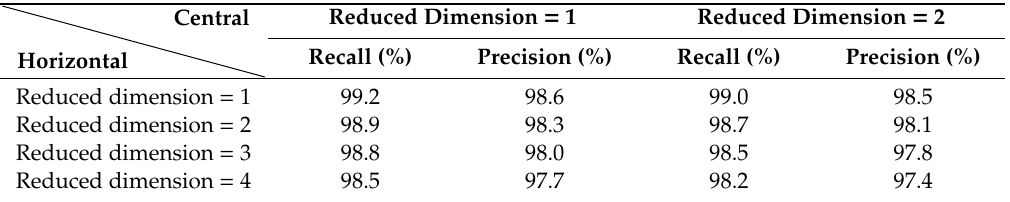
Table 5. Central and horizontal reduction results.